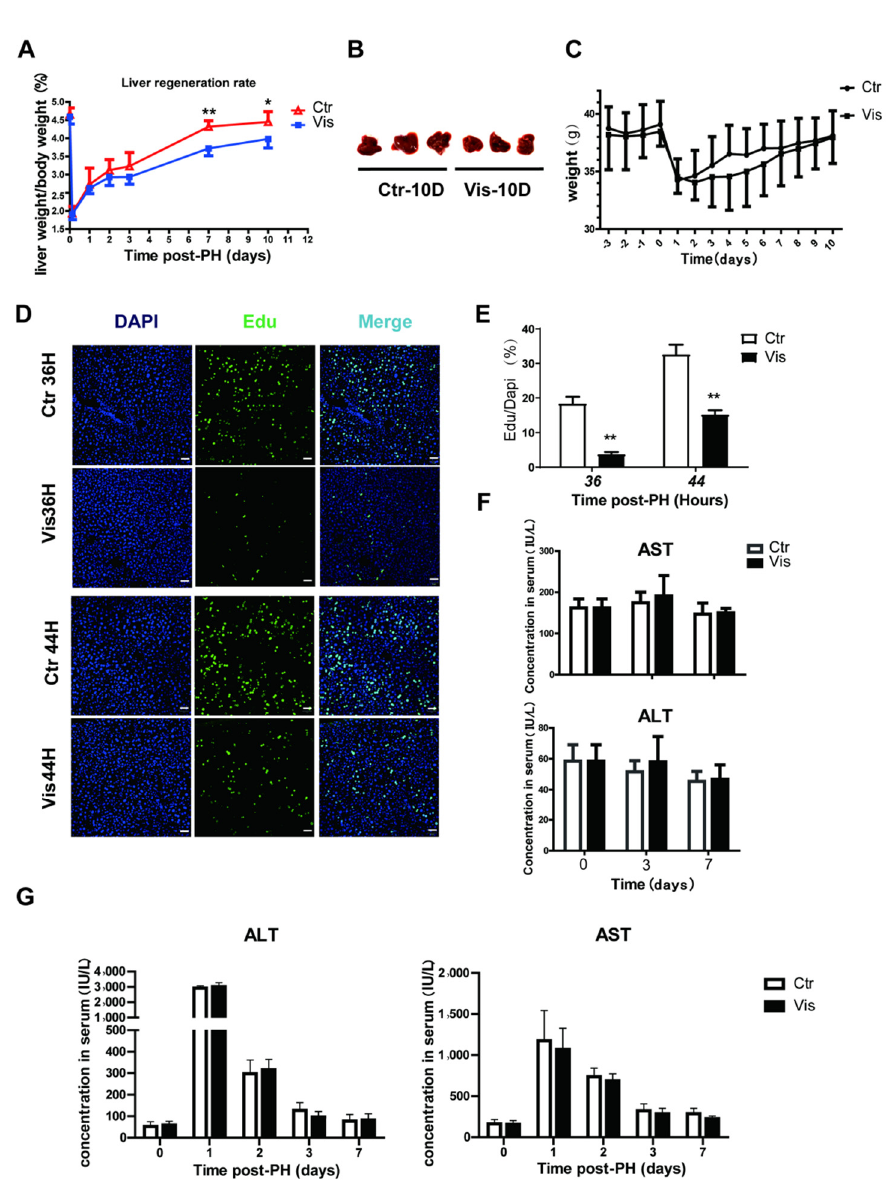
Figure 2. Vismodegib suppresses the rate of liver regeneration after PH. ( A ) Liver-to-body weight ratios of control and vismodegib-treated mice at different times after 70% partial hepatectomy (0, 3 h, 1 day, 2 days, 3 days, 7 days and 10 days), n = 5. ( B ) Images of mouse livers at 10 days post-PH between the two groups, n = 3. ( C ) The change in the body weight of the control and vismodegib- treated mice between 3 days pre-PH and 10 days post-PH; the trends of the two groups were consistent, n = 5. ( D ) Edu was used to analyze the difference in proliferative cell amounts between the normal and vismodegib-treated groups after PH. Representative immunofluorescence results 36 h and 44 h after PH. ( E ) Quantification percentage of Edu positive cells to DAPI positive cells shown in the histogram. ( F ) Changes in liver function index of normal mice treated with vismodegib (AST: aspartate aminotransferase, ALT: alanine aminotransferase) at different times (0, 3, 7 days). There was almost no difference between the two groups, n = 5. ( G ) Changes in liver function index (ALT and AST) of mice at different times post-PH in the two groups, n = 5. All data represent means ± SEM. * p < 0.05, ** p < 0.01 vs. control group.